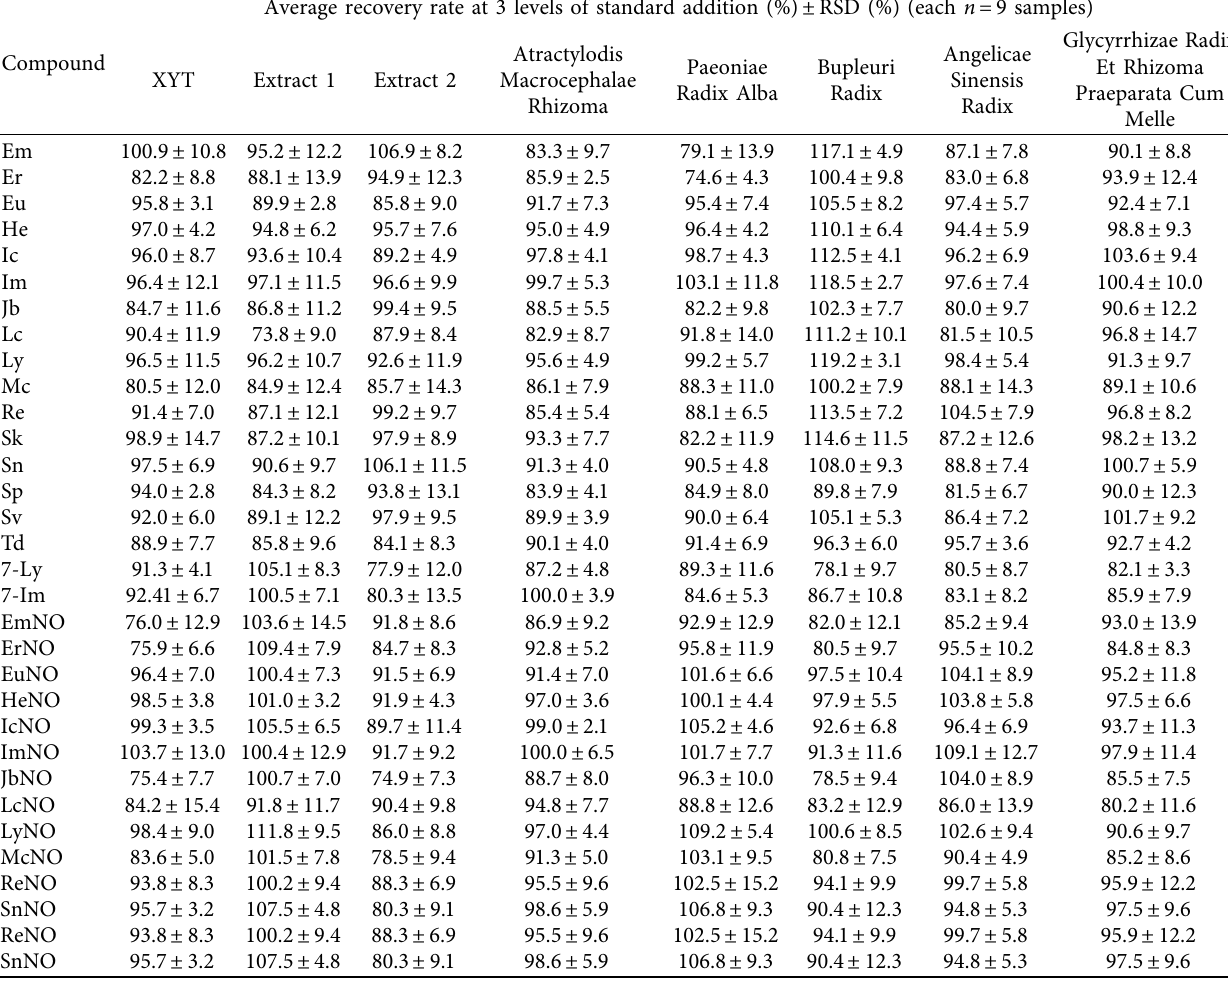
Table 5: Mean recoveries and repeatability of the method for PAs in the XYT.